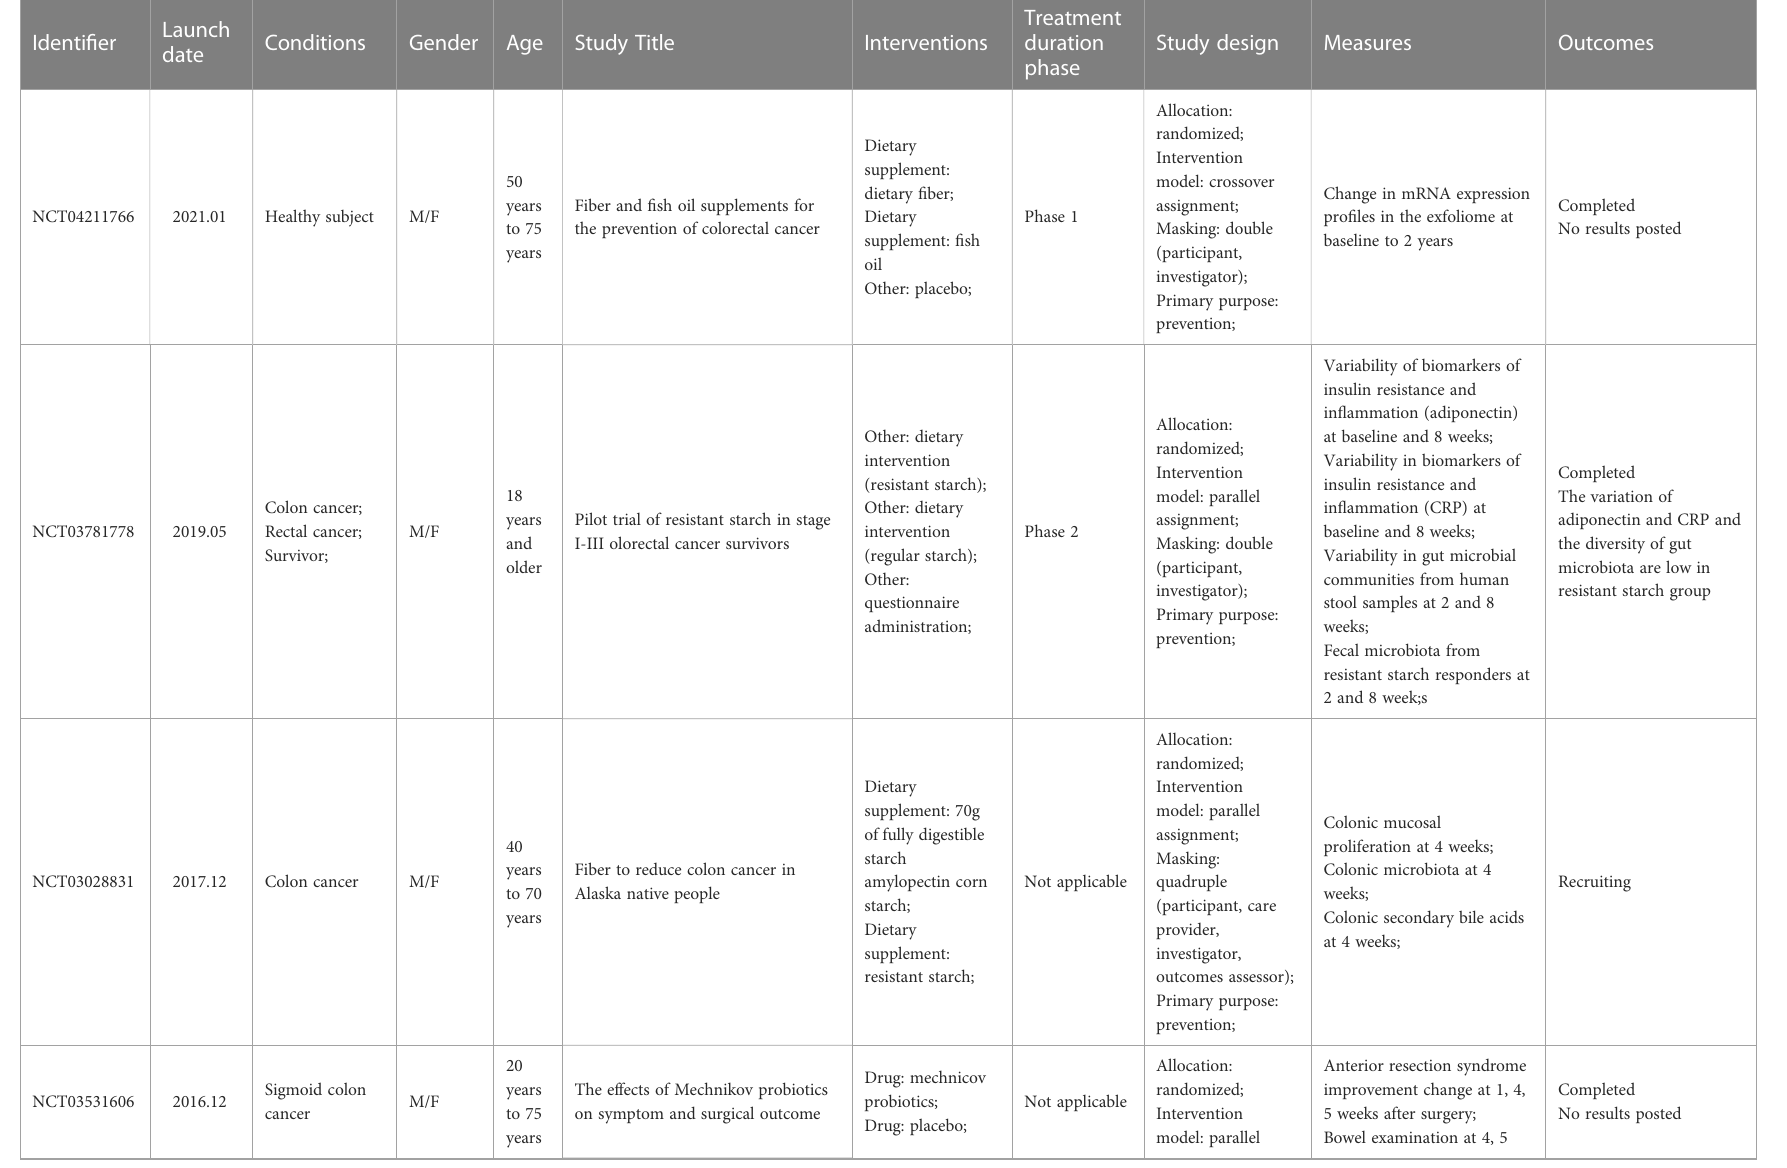
TABLE 2 Approved clinical trials explore the effects of short-chain fatty acids on the treatment and prognosis of patients with colorectal cancer (Data sources: